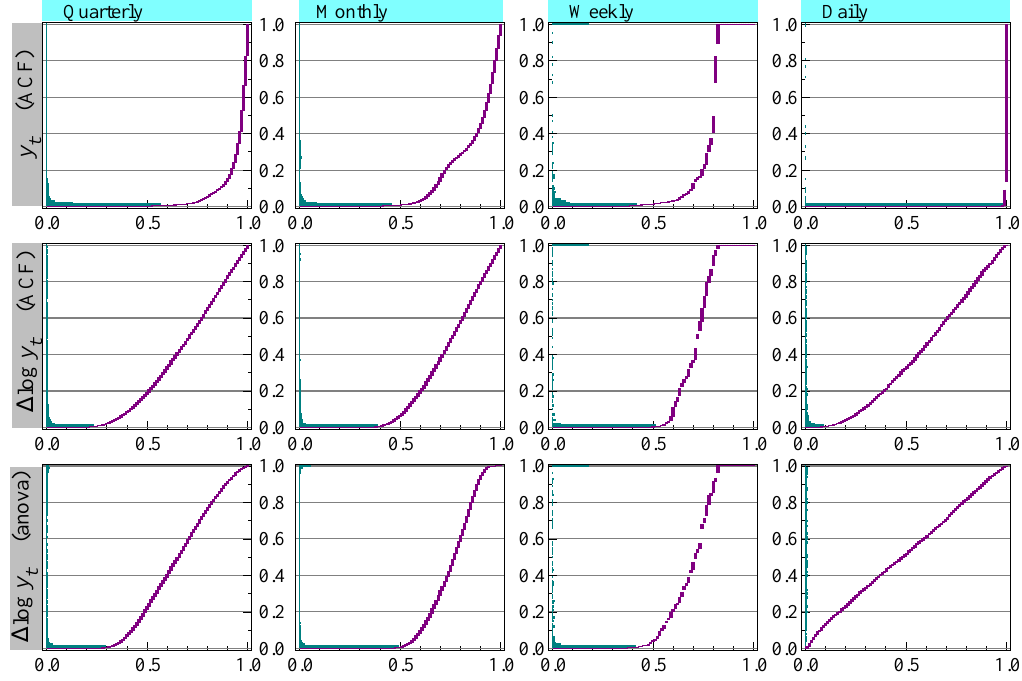
Figure 4. Tests of seasonality for quarterly, monthly, weekly and daily (with S = 5) M4. First row for y t , second row for ∆ log y t , third row seasonal ANOVA test for